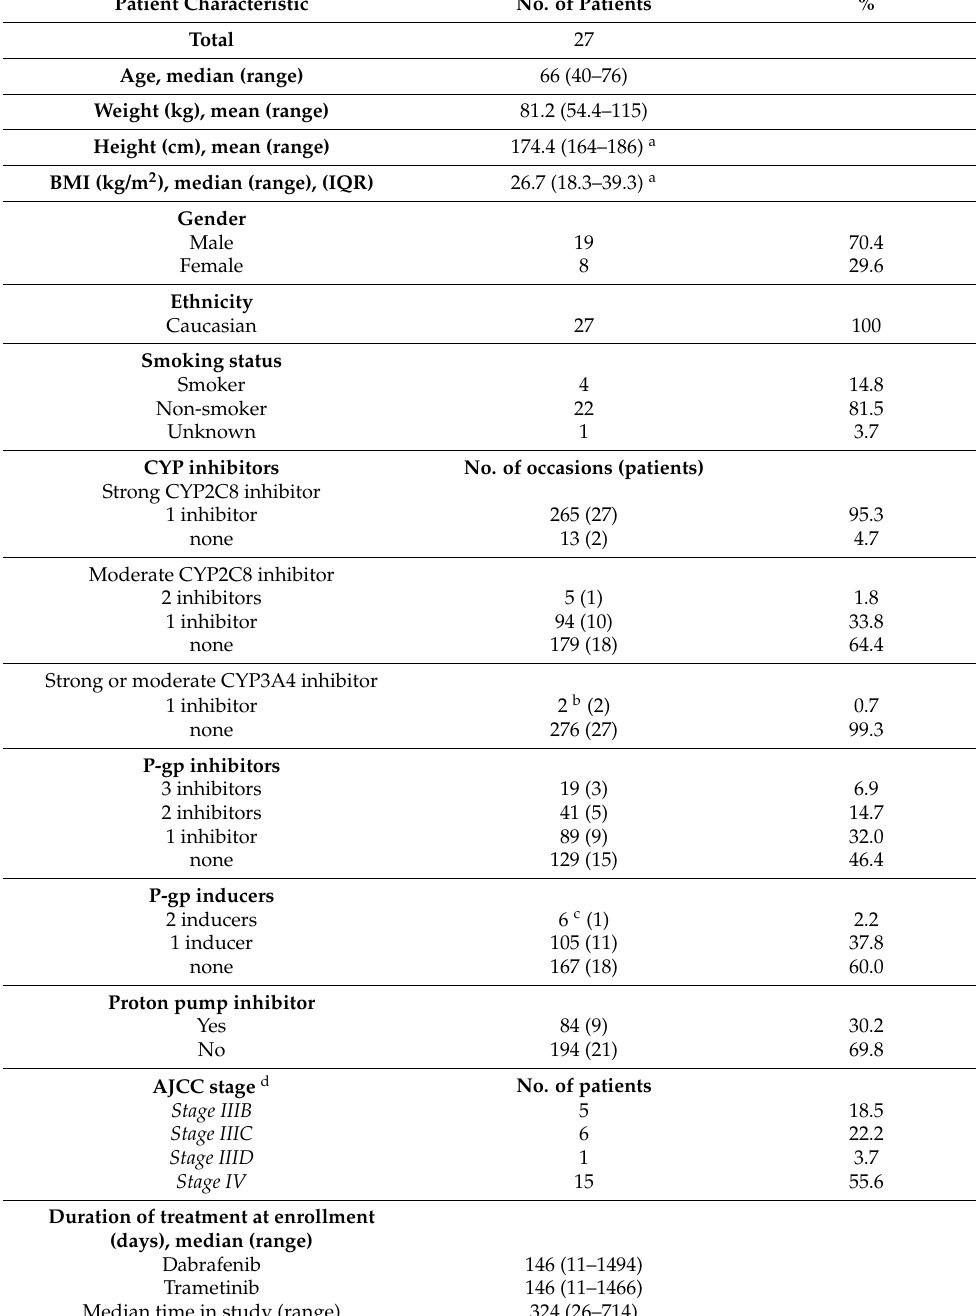
Table 1. Baseline patient